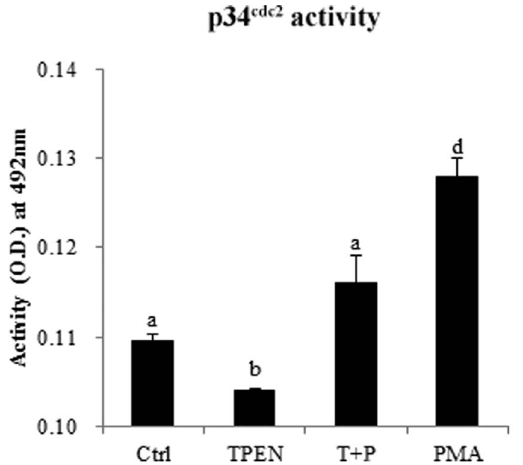
Figure 7. TPEN treatment reduces p34 cdc2 kinase activity in porcine oocytes. p34 cdc2 kinase activity was examined in oocytes after 25 h of IVM in the absence (Ctrl, control group) or presence of TPEN, PMA, or TPEN plus PMA (T + P). Twenty oocytes were examined per group. Data are expressed as mean values 6 SEM. Different letters above the bars denote statistically significant differences (P ,